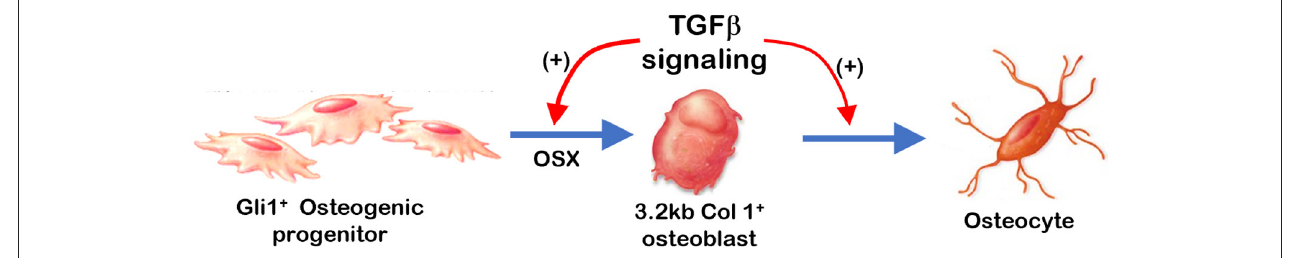
FIGURE 7 | Summary: TGF β signaling plays a stage-dependent role during mandible bone growth based on the loss of Tgf β r2 in Gli1 + osteogenic progenitors and 3.2kb Col1 + osteoblasts in the R26R tdTomato tracing background, respectively. Removing Tgf β r2 in the Gli1 + progenitor cells at early postnatal stage led to a significant bone loss and a decrease in OSX. Deletion of Tgf β r2 in the 3.2kb Col1 + osteoblasts at early postnatal stage result in mild changes in alveolar bone morphologies and bone